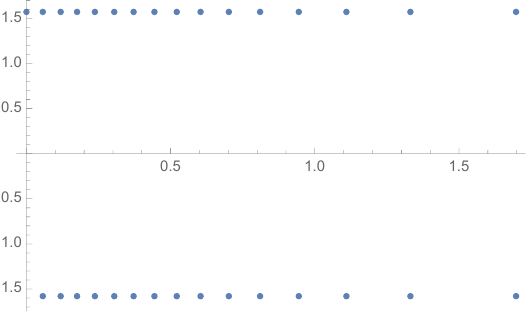
Figure 12 . Bethe roots for L = 32. Lowest-energy state in the n = 1 sector with (cid:13) = (cid:25)